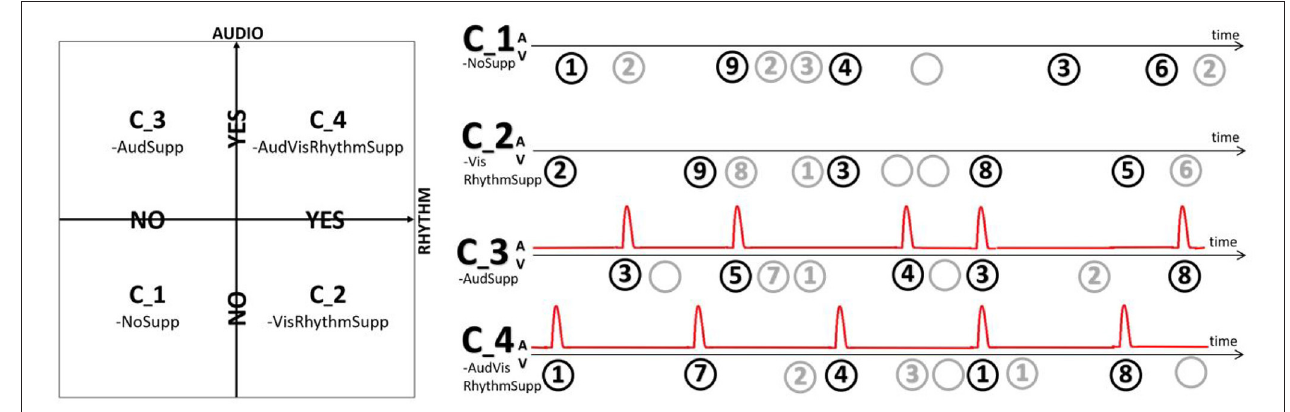
scores are evaluated, each of them being more sensitive to